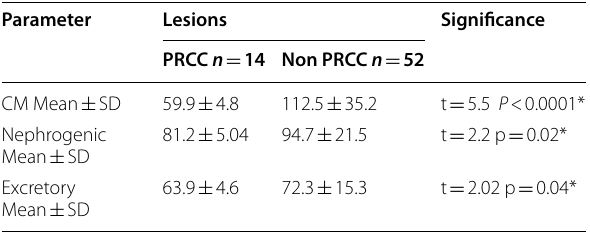
Table 4 Comparison betwean PRCC and Non PRCC in enhanced phase